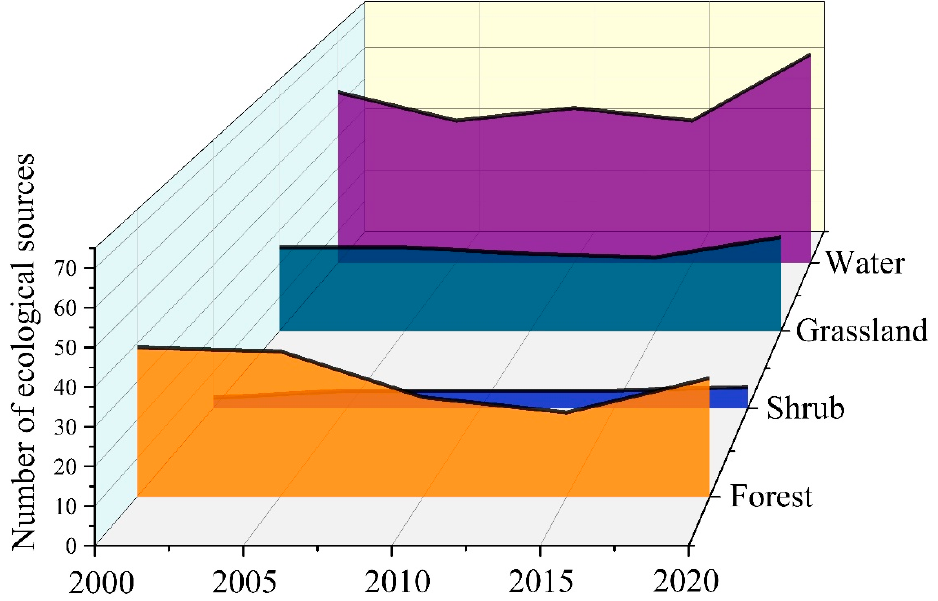
Figure 5. Changes in the number of different types of ecological sources .